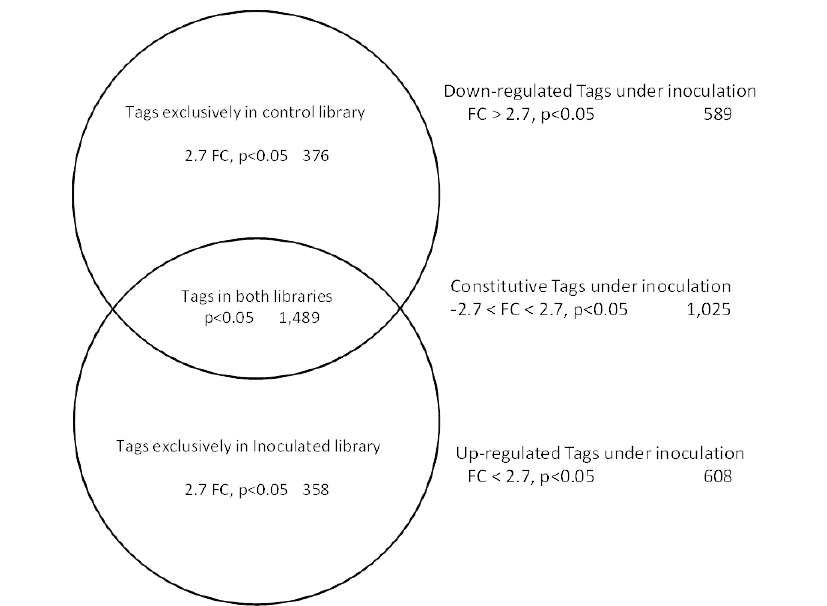
Figure 2. Venn diagram of the quantitative tags classification into down-regulated, constitutively expressed, and up-regu - lated transcripts in control and inoculated faba bean leaves. Only tags matching 26 bp and with a P <0.05 were taking into account to build the